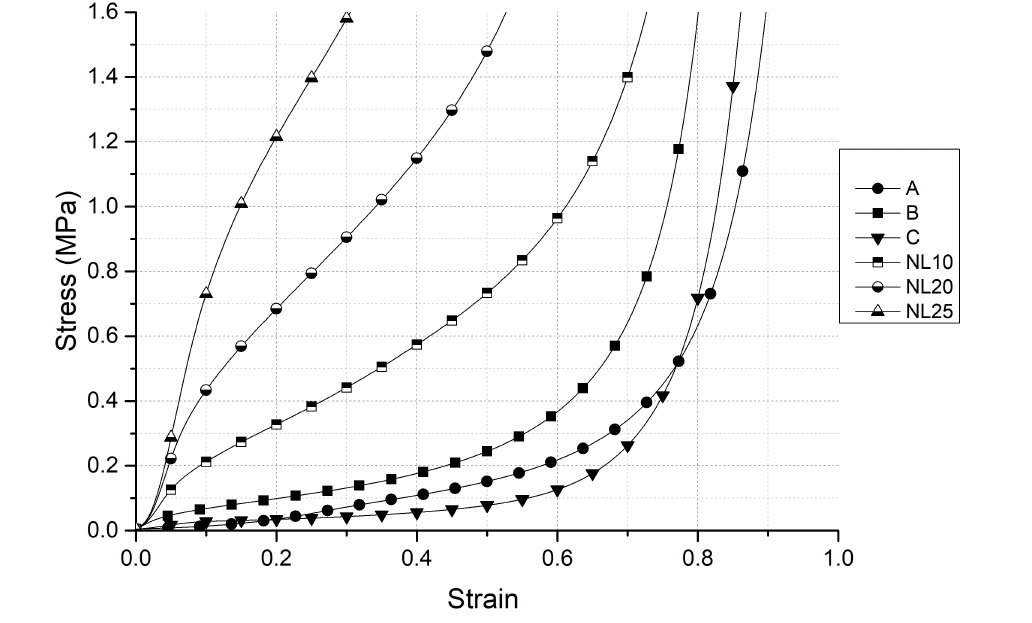
Figure 2. Stress-strain curves in quasi-static uniaxial compression